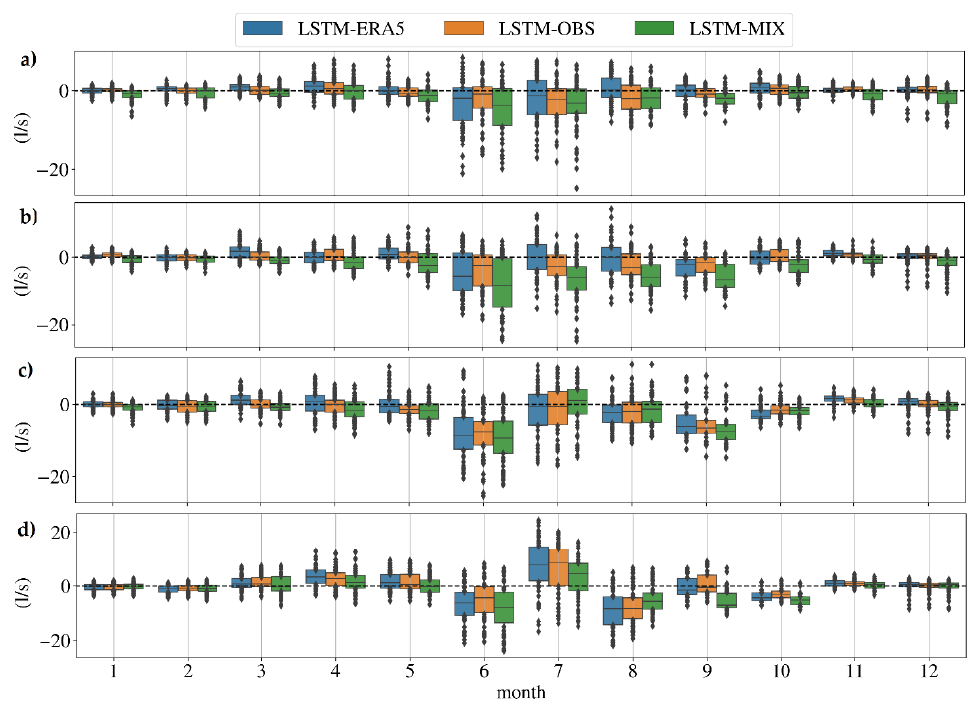
Figure 5. Absolute errors aggregated to the month for case study 2. Modelled absolute errors for LSTM-ERA5 (blue), LSTM-OBS (orange), and LSTM-MIX (green). ( a ) 7 days horizon, ( b ) 14 days horizon, ( c ) 30 days horizon, and ( d ) 60 days horizon.